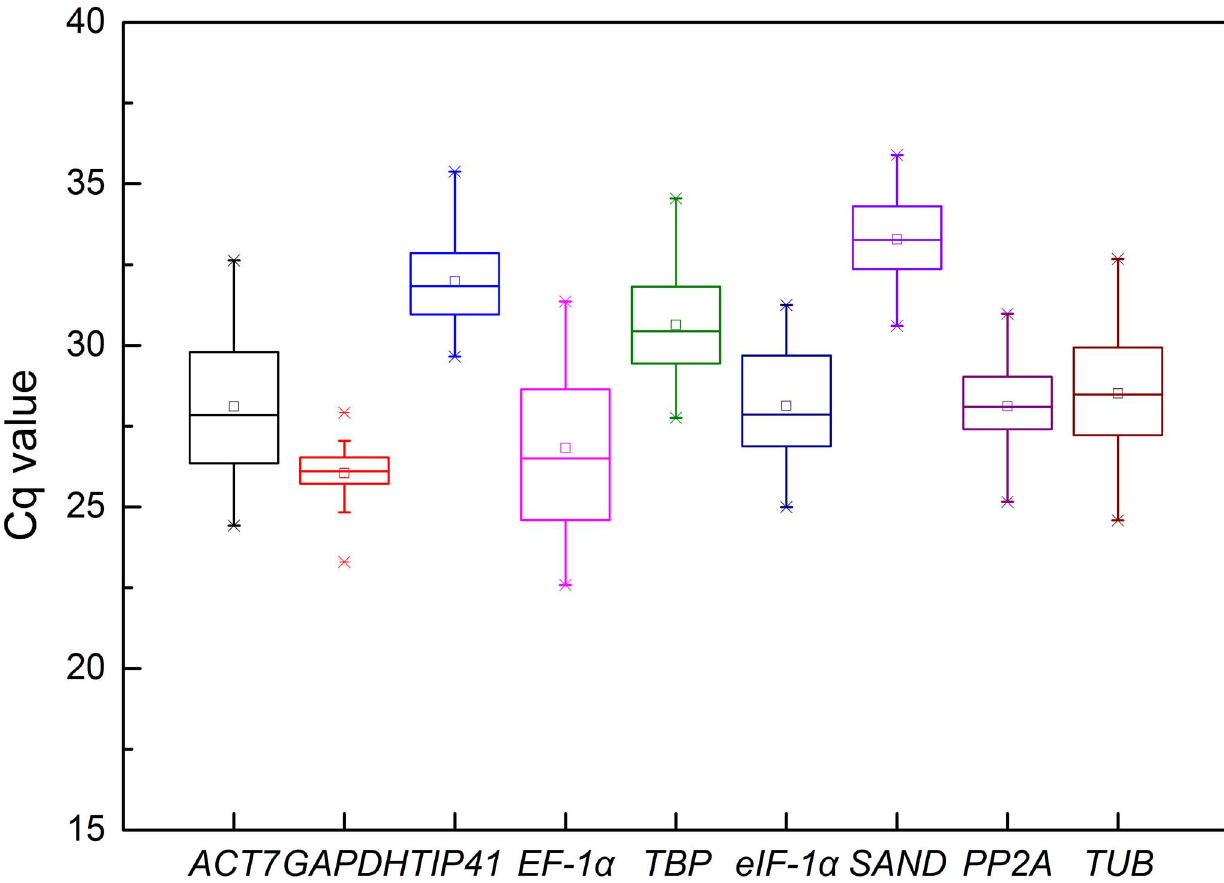
Figure 1. Cq values of candidate reference genes in all samples of O.javanica . The line across the box depicts median. The inside box depicts mean. The outside box is determined by the 25th and 75th percentiles. The whiskers are determined by the 5th and 95th percentiles. The asterisk represents outlier.